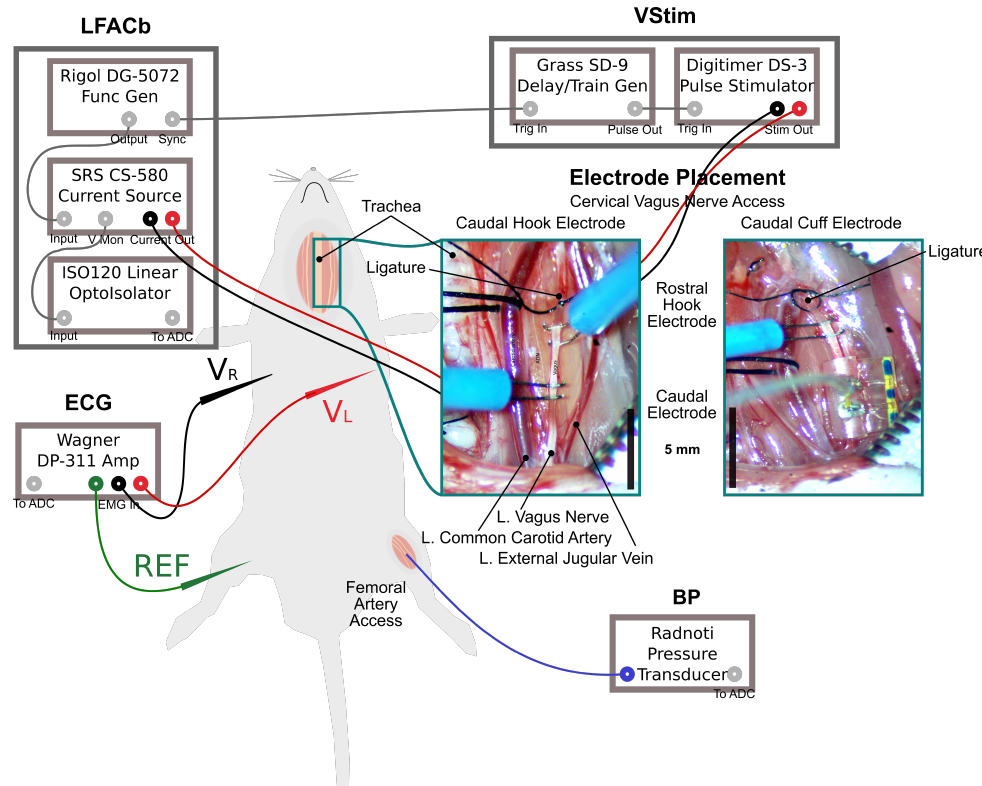
Figure 1. Instrumentation and electrode placed in the cervical vagus nerve access. The Electrode Placement panels show a magnified view of the cervical vagus nerve access in two cases with a 5 mm scale bar: (left) with the caudal electrode as a hook and (right) as a cuff electrode. The rostral electrode was always a hook electrode. The electrodes are shown wired only in the hook electrode panel for simplicity. A ligature was placed rostral to both electrodes to eliminate left cranial reflexes. The hook electrode panel shows the ligature tied, while the cuff electrode panel shows the ligature just prior to closure. Additionally, the left vagus nerve was crushed with forceps, as shown in the left panel, to further ensure that reflexes were excluded. The right vagus nerve was left intact and not crushed for stability.The signals recorded from the instrumentation were the amplified ECG, the voltage drop across the LFACb electrodes, and the arterial blood